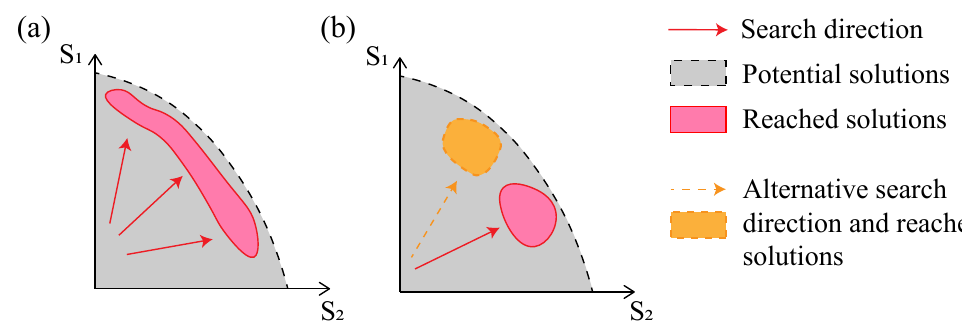
Figure 1. Searching scheme of NSGA2 and SBGA. ( a ) NSGA2 retains a front formed by the solutions in each generation. ( b ) SBGA reduces the problem to one dimension in the score space and searches in a specific direction (NSGA2: Non-dominated Sorting Genetic Algorithm II, SBGA:Scoring-Based Genetic